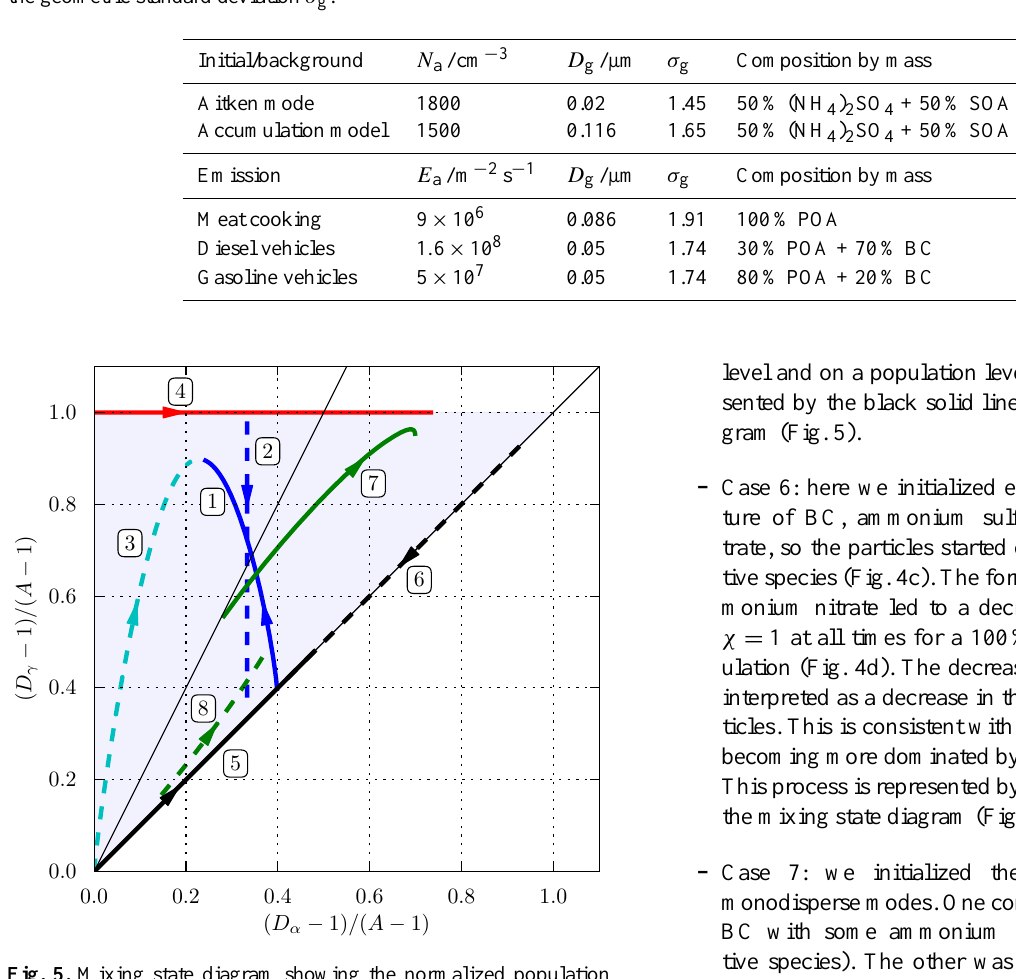
Fig. 5. Mixing state diagram showing the normalized population species diversity D γ versus the normalized average particle species diversity D α for all single-process cases. The number labels refer to the cases defined in Table 6 and shown in Figs. 3 and